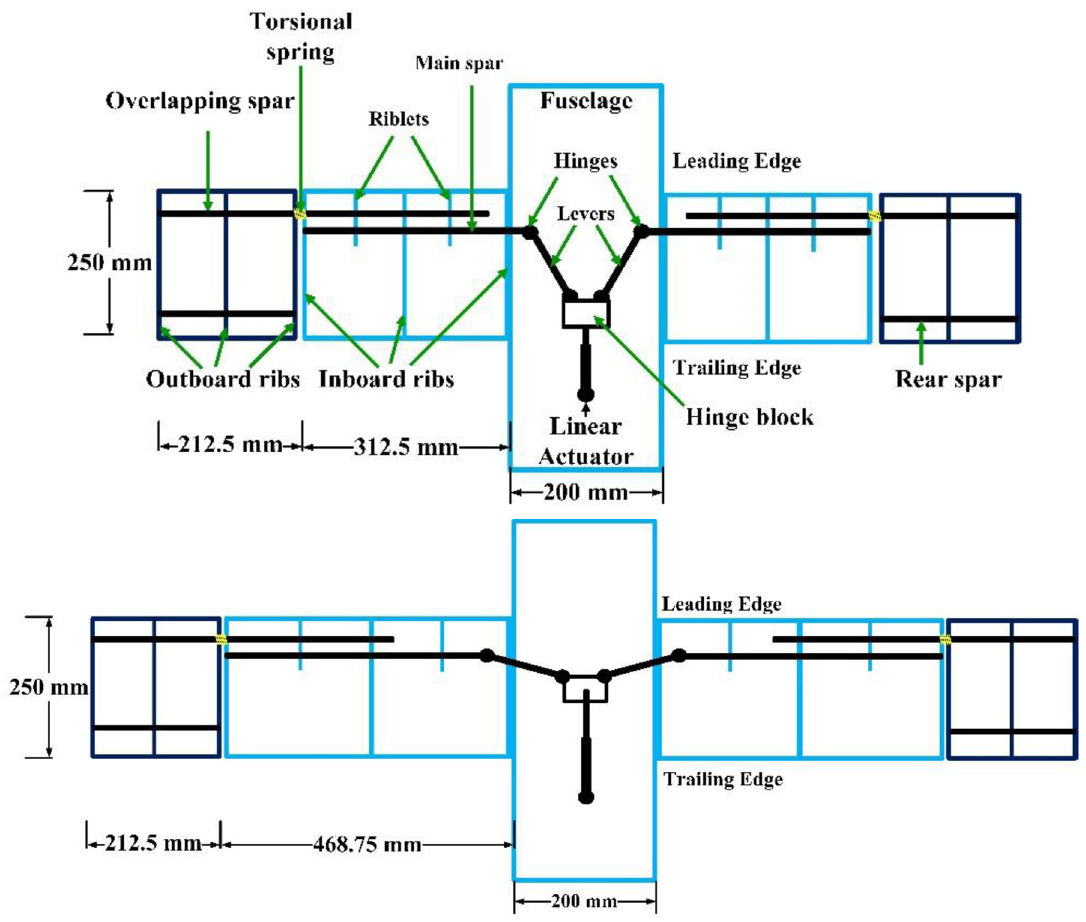
Figure 1. ASAPP wing before ( top ) and after ( bottom ) span extension [9].